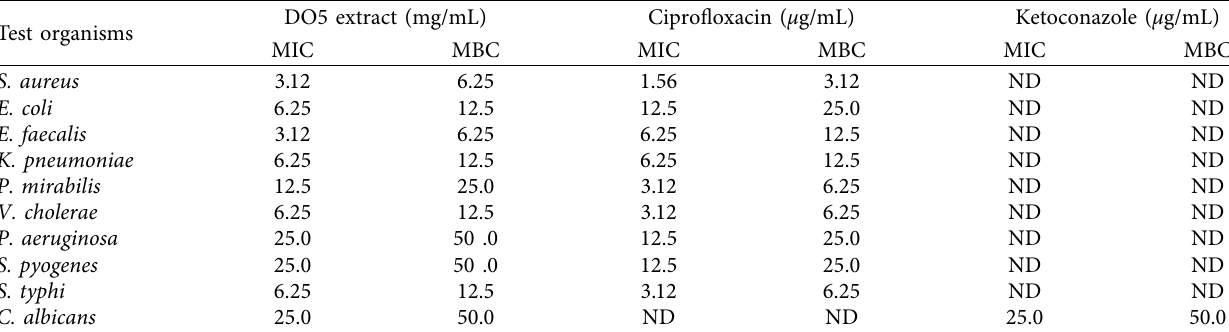
Table 6: MIC and MBC of DO5 extract, ciprofloxacin, and ketoconazole. Test organisms